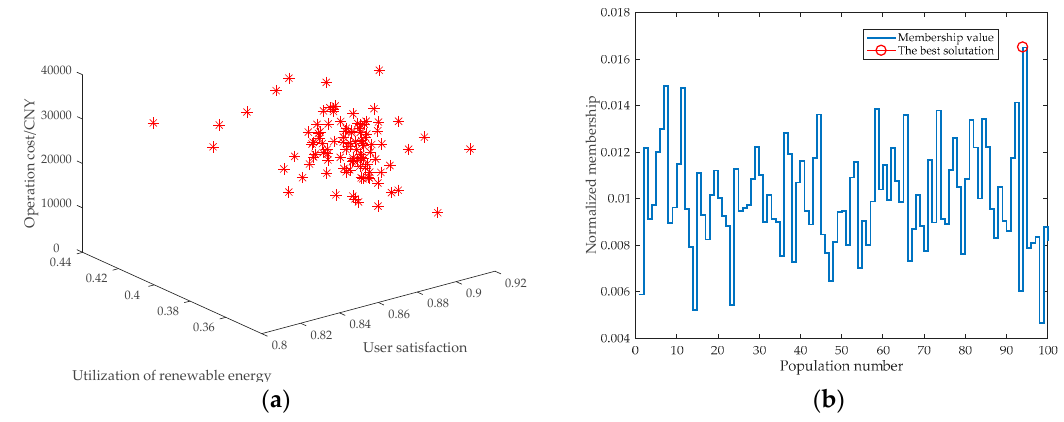
Figure 9. Multiobjective optimization results: ( a ) Pareto fronts under source–network–load optimization, and ( b ) normalized membership functions of different Pareto solutions.